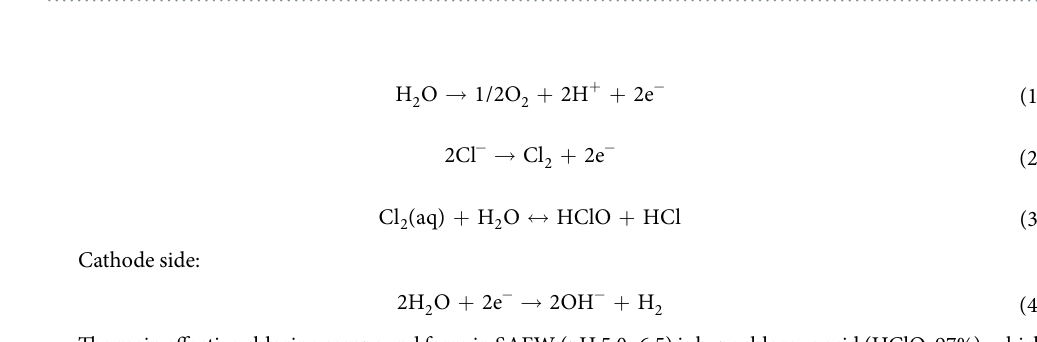
Figure 1. Schematic diagram of a slightly acidic electrolyzed water